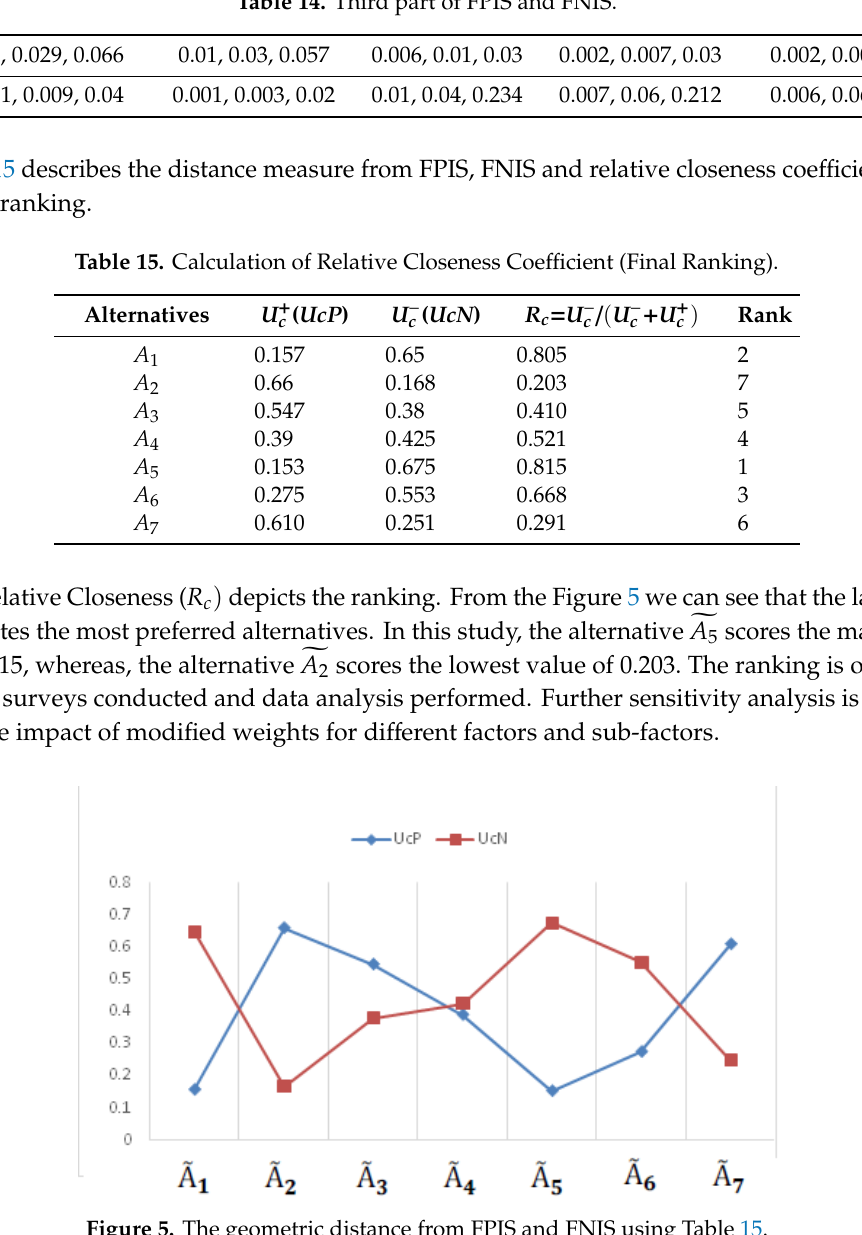
Figure 5. The geometric distance from FPIS and FNIS using Table 15.